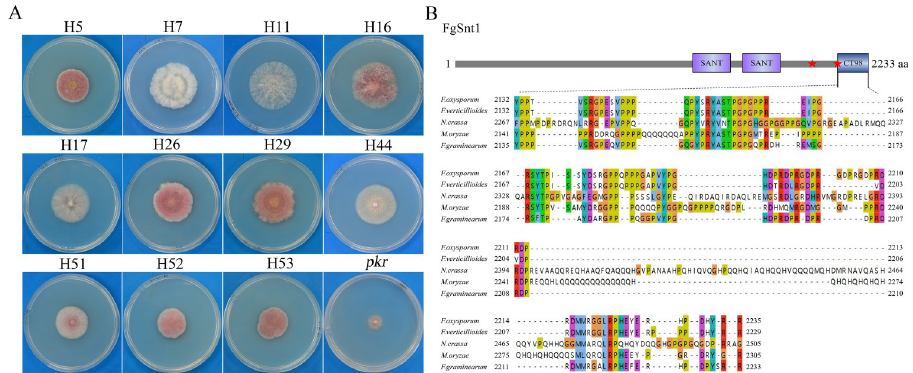
Fig 1. Suppressors of pkr with mutations in FgSNT1 and structural features of FgSnt1. (A). Three-day-old PDA cultures of the pkr mutant and marked suppressors with mutations in FgSnt1. (B). Schematic drawing of the FgSnt1 protein and alignment of its C-terminal 98-aa with orthologs from Magnaporthe oryzae (Mo), Neurospora crassa (Nc), F . oxysporum (Fo), and F . verticillioides (Fv). Stars mark the sites of suppressor mutations. SANT, SANT domain; CT98, the C-terminal 98-aa of FgSnt1. https://doi.org/10.1371/journal.pgen.1010510.g001 slightly reduced (less than 20% reduction) in conidiation compared to PH-1 but it produced over two-fold more conidia than the Fgsnt1 mutant (Table 3). In infection assays with wheat heads, the Fgsnt1 and FgSNT1 Δ CT98 deletion mutants were still pathogenic and caused typical head blight symptoms on inoculated spikelets (Fig 3D).